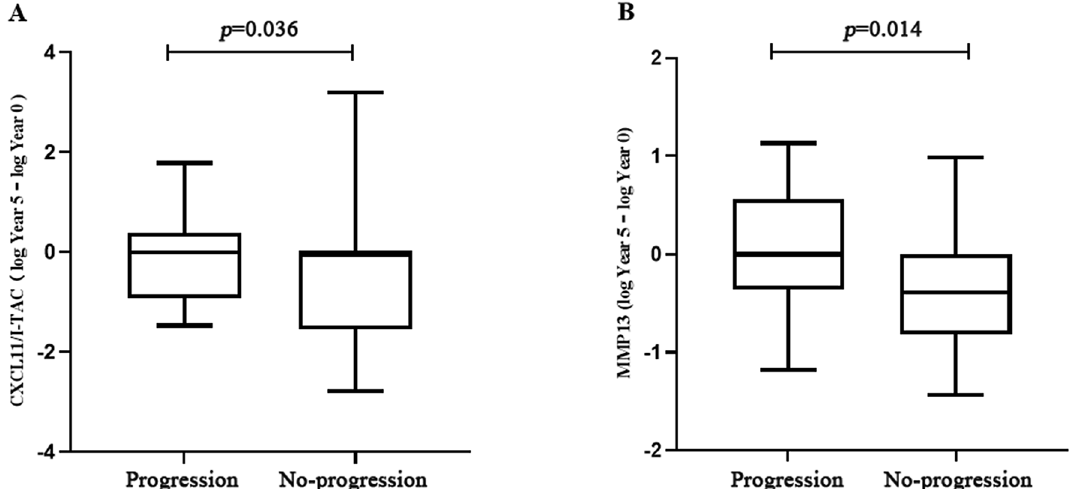
Figure 2. Relationship between changes in serum levels of biomarkers from Year 0 to Year 5 and radiographic outcome. Box plots demonstrate that serum levels of A) CXCL11/I-TAC and B) MMP-13 from Year 0 to Year 5 (log Year 5—log Year 0) (y-axis) were significantly associated with RA-ILD outcomes (progression versus no-progression, x-axis), as assessed by changes in Quantitative Modified ILD scores ( p = 0.036 and p = 0.014 for CXCL11/ITAC and MMP-13, respectively). Horizontal bars signify median FVC criteria, 19 (49%) remained unchanged/stable, and 13 (33%) improved (data not shown). Correlation with HRCT-based determination of disease progression was relatively strong, as 28/39 (72%) patients undergoing both PFTs and HRCT at study entry and Year 5 were similarly classified as progressors versus non-progressors whether disease course was assessed by changes in FVC% or changes in radiographic ILD scores.